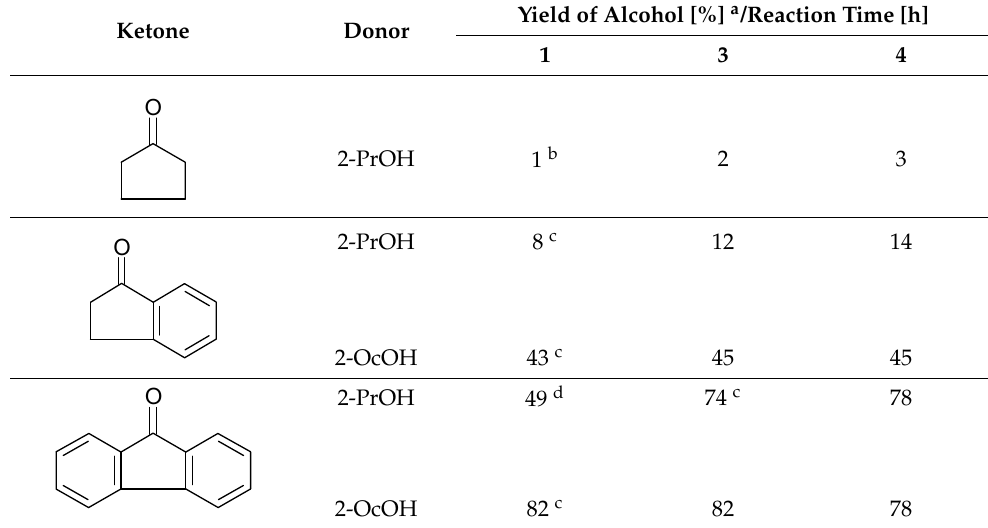
Table 4. Liquid phase transfer hydrogenation of polycyclic derivatives of cyclopentanone with secondary alcohols in the presence of MgO.